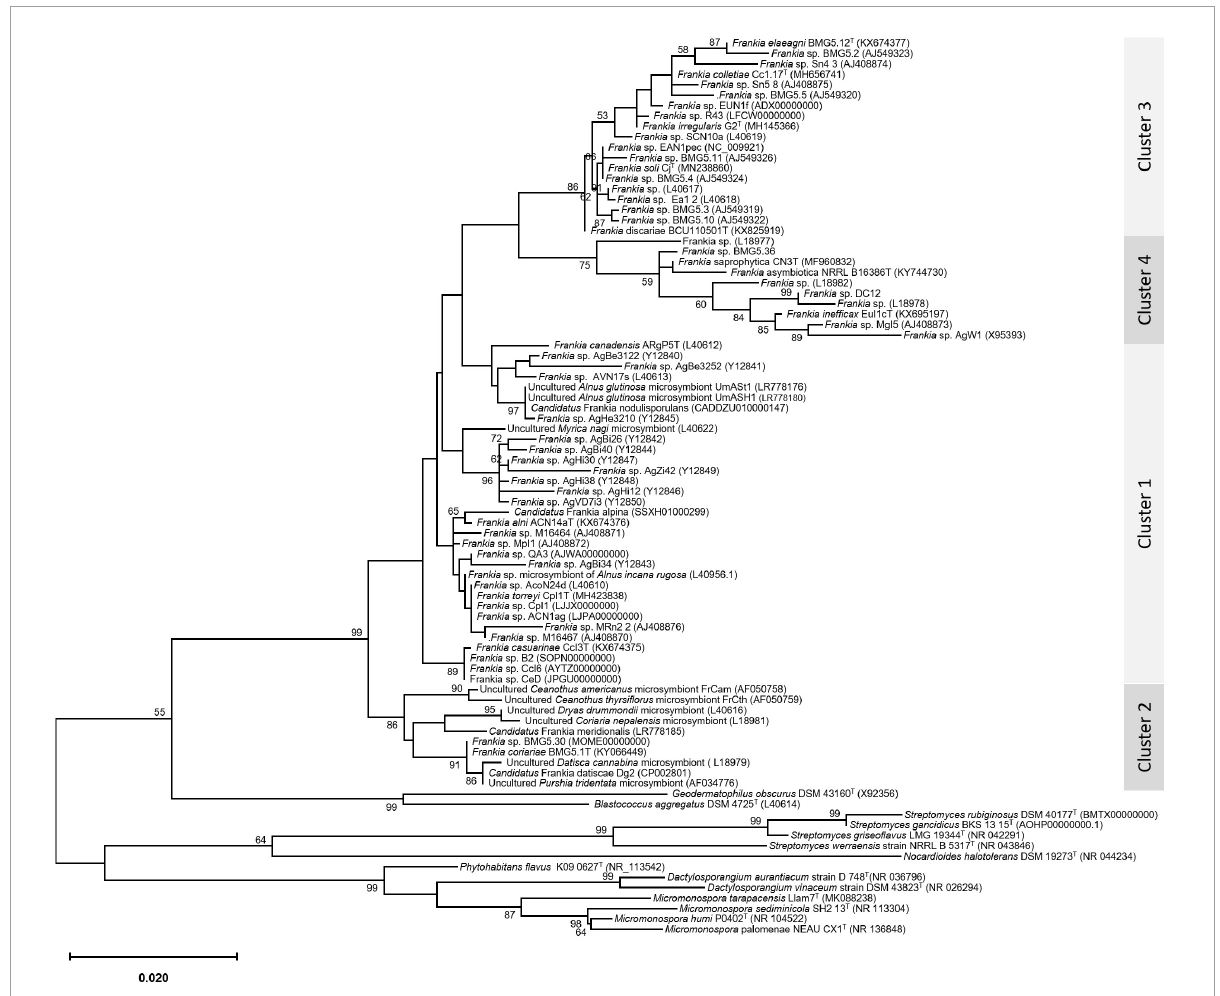
FIGURE1 A maximum-likelihood tree based on the 16s rRNA gene sequences of 72 members of the genus Frankia . The maximum-likelihood (ML) tree was inferred using the GTR + GAMMA model and rooted by midpoint rooting, and the branches are scaled in terms of the expected number of substitutions per site. The numbers above the branches support values when larger than 60%